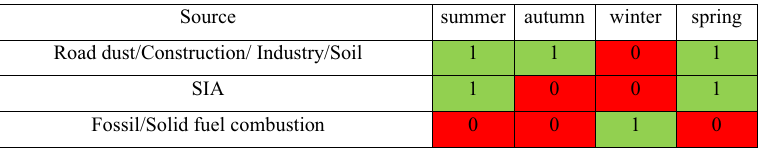
Table 3. Wilcoxon rank sum test results for sources: 1 indicates a rejection of the statement that medians are equal; 0 indicates a failure to reject the statement that medians are